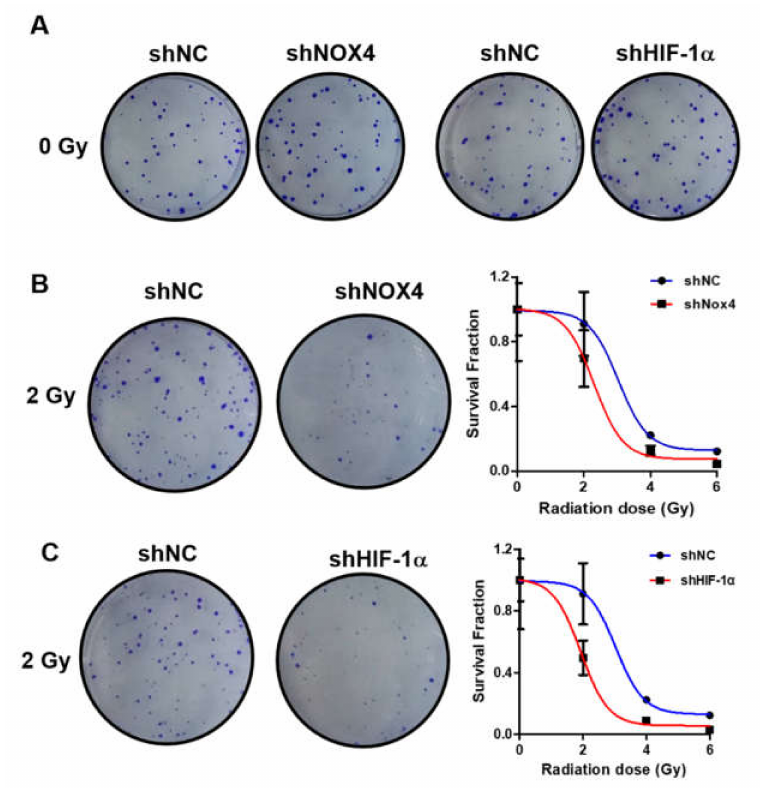
Figure 5. Knockdown of NOX4 and HIF-1 α increased cell sensitivity to radiation treatment of cancer cells. ( A – C ) Knockdown of NOX4 and HIF-1 α in OVCAR3 cells was performed using shNOX4 and shHIF-1 α , radiation treatment was performed at 48 h after transfection. The number of cell clones were counted, and levels of survival cells were